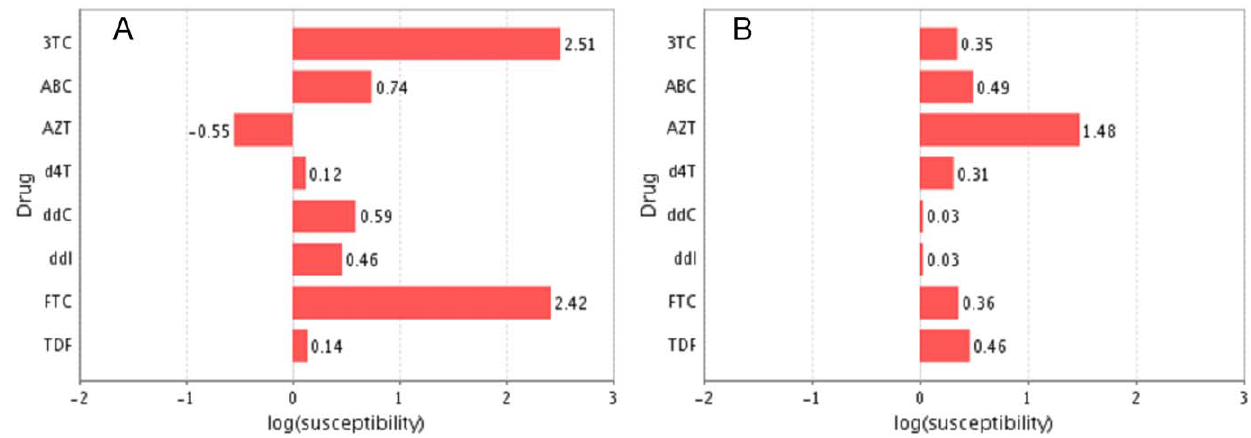
Figure 3. Prediction server for NRTI susceptibility. Shown are screenshots from the output from the web-page at www.hivdrc.org, utilizing the web-service based on the proteochemometric model ( Model-3 ). Shown are the predicted susceptibilities for the eight NRTIs covered by the model for two sets of HIV mutant strains; K65R + M184V (panel A), and M41L + L210W + T215Y (Panel B). The web service takes an HIV-1 RT sequence as input and predicts the virus susceptibility to the NRTIs using the unified proteochemometric model.